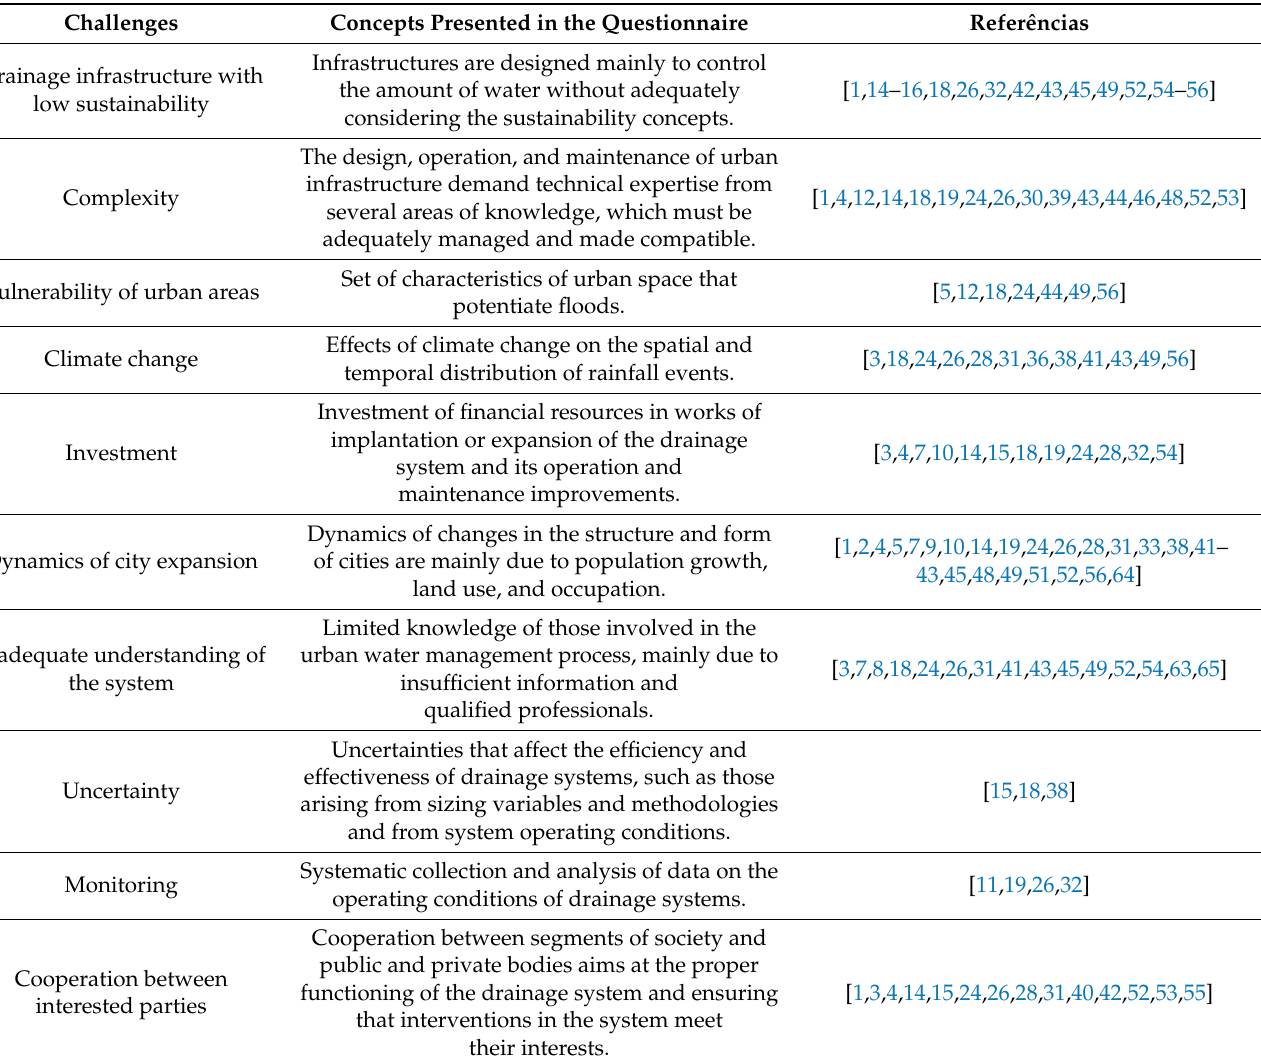
Table 5. Selected